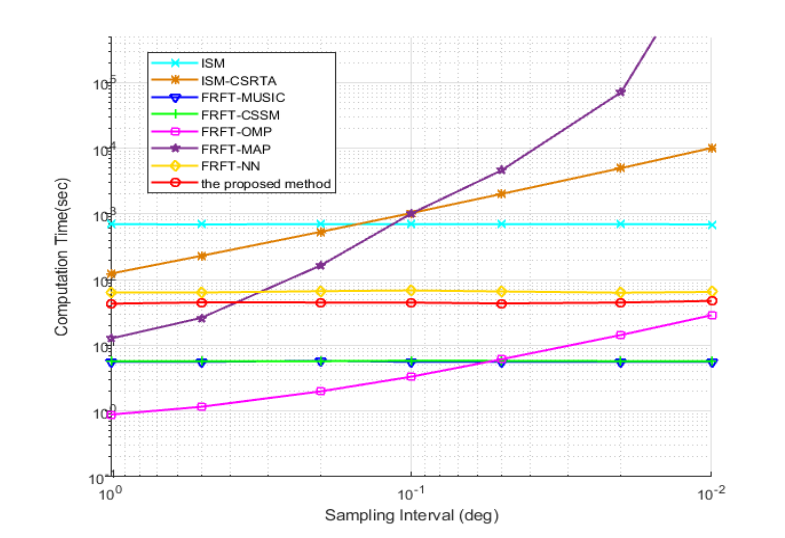
Figure 12. The computation time of DOA estimations vs. the sampling